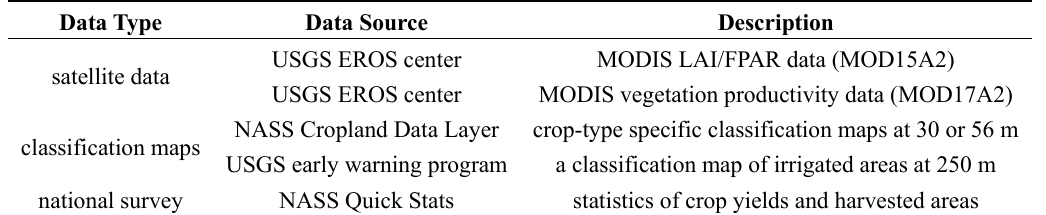
Table 1. The datasets used in this